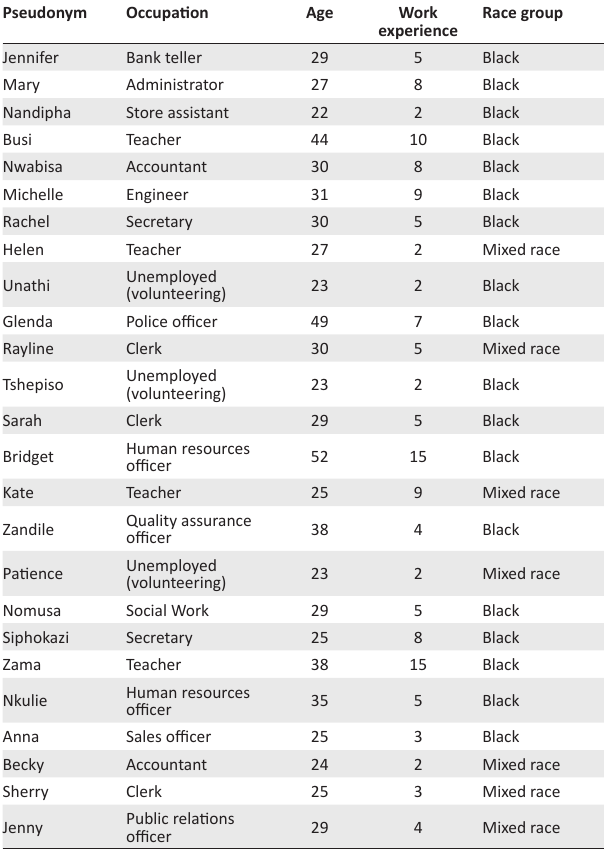
TABLE 2: The characteristics of the respondents.